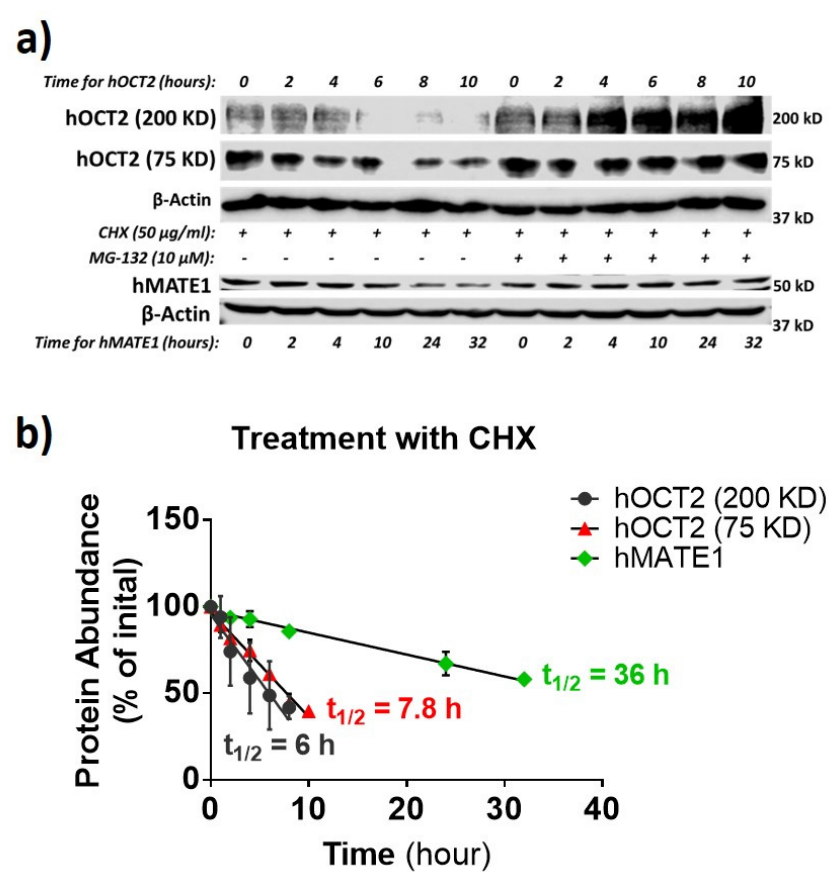
Figure 6. hMATE1 has a much longer half-life than hOCT2. ( a ) IB analysis of hOCT2 and hMATE1 after being exposed to translation inhibitor cycloheximide (CHX) or CHX plus MG-132 (proteasome inhibitor) at indicated times. β -actin is used as the loading control. ( b ) Calculation of the protein degradation rate as half-life (t1⁄2), by fitting the data with a linear regression mode. Half-lives of hOCT2 and hMATE1 were determined as the time of 50% degradation achieved under CHX treatment.